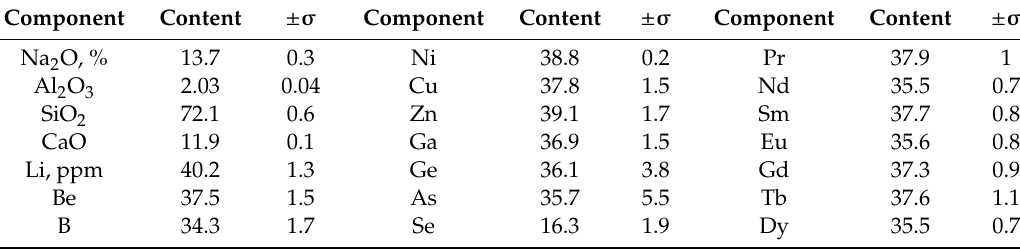
Table A1. Composition of the NIST 612 standard [47], Analytic Center of IGM SB RAS.